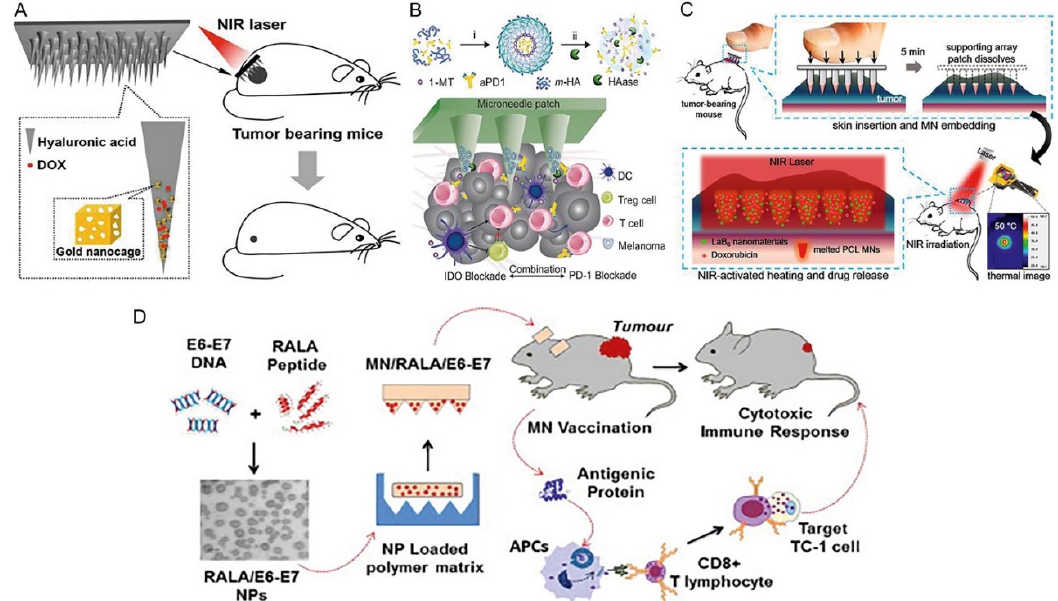
Figure 6. ( A ) Treating superficial tumors synergistically using chemotherapy and photothermal therapy. Dissolvable microneedles fabricated from hyaluronic acid (HA) were loaded with DOX. The drug-loaded microneedles were then incorporated with gold nanocages and exposed to near-infrared light, thereby combining chemotherapy and photothermal therapy. Adapted with permission from [83]. Copyright © 2021, American Chemical Society. ( B ) Microneedle-based melanoma immunotherapy. An anti-PD1 antibody was loaded onto an HA-based microneedle delivery system thereby combining PD1 and 1-MT to impede the enzyme, IDO, as an immunotherapeutic strategy for melanoma. Adapted with permission from (Wang et al., 2016a). Copyright © 2021, American Chemical Society. ( C ) Dissolvable PVA/PVP containing a polycaprolactone formulation was used to fabricate a light-sensitive microneedle patch. The polycaprolactone was composed of a chemotherapeutic drug, DOX, and photothermal nanoparticles which both acted in synergy for the treatment of dermal tumors. Upon exposure to near-infrared light, the microneedle patch melted at 50 °C and released DOX for local therapy. Reproduced with permission from [84]. Copyright © 2021, American Chemical Society. ( D ) The treatment of cervical cancer by applying a polymeric polyvinylpyrrolidone microneedle patch comprised primarily of the peptide RALA and DNA vaccine. Reproduced with permission from [85].